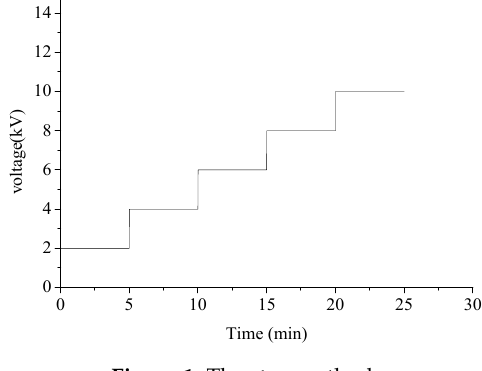
Figure 1. The step method.